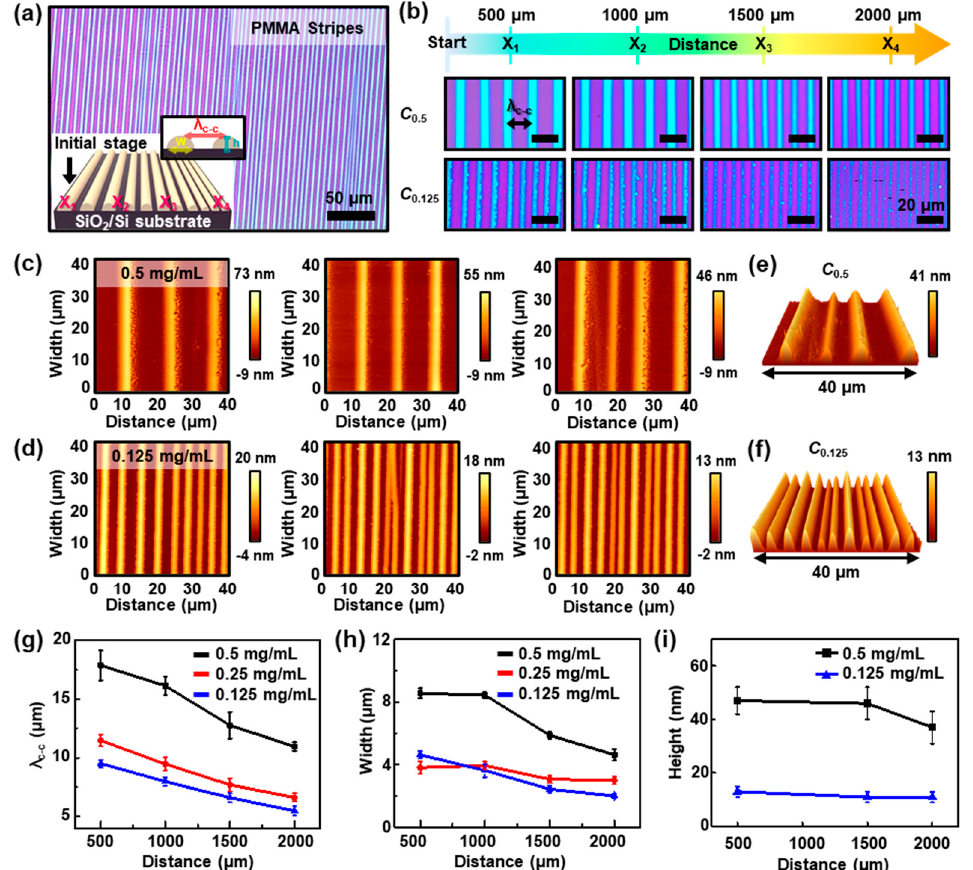
Figure 2. ( a ) An optical micrograph of a highly regulated array of PMMA stripes on the SiO 2 / Si substrate with a concentration of 0.125 mg mL − 1 ; the inset is the schematic drawing, in which the value of λ c-c indicates the typical center-to-center distance between two adjacent stripes; X 1 , X 2 , X 3 , and X 4 denote the distances of PMMA stripes away from the initial stage. ( b ) Optical micrographs of periodically patterned stripe arrays of PMMA with varied concentrations ( C = 0.5 and 0.125 mg mL − 1 ); the images were measured at the di ff erent locations; scale bars are 20 µ m for all images. ( c , d ) Atomic force microscopy (AFM) images of the PMMA stripes formed on the SiO 2 / Si substrate, collected from the initial (left) to final (right) stages from concentration with 0.5 mg mL − 1 and 0.125 mg mL − 1 , respectively. ( e , f ) The 3D topological AFM images from the concentration of 0.5 and 0.125 mg mL − 1 , respectively; the scan position was in 2000 µ m ( X 4 region) with a size of 40 × 40 µ m 2 . ( g – i ) The measured gradient values of λ c-c , w , and h at di ff erent locations, depending on the concentration of the PMMA solution, respectively.